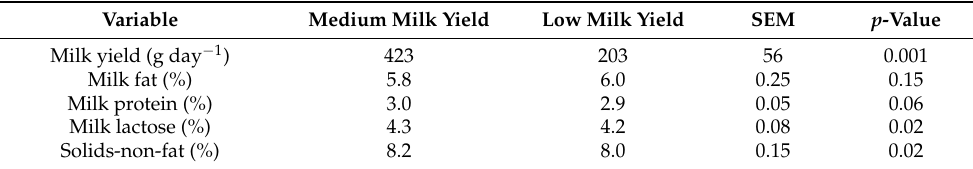
Table 2. Milk yield and composition (fat, protein, lactose, solids-non-fat) from non-supplemented mixed-breed goats reared on a Xerophytic ecosystem in northern Mexico during the dry season (winter–spring) with different milk yielding potentials (medium vs.